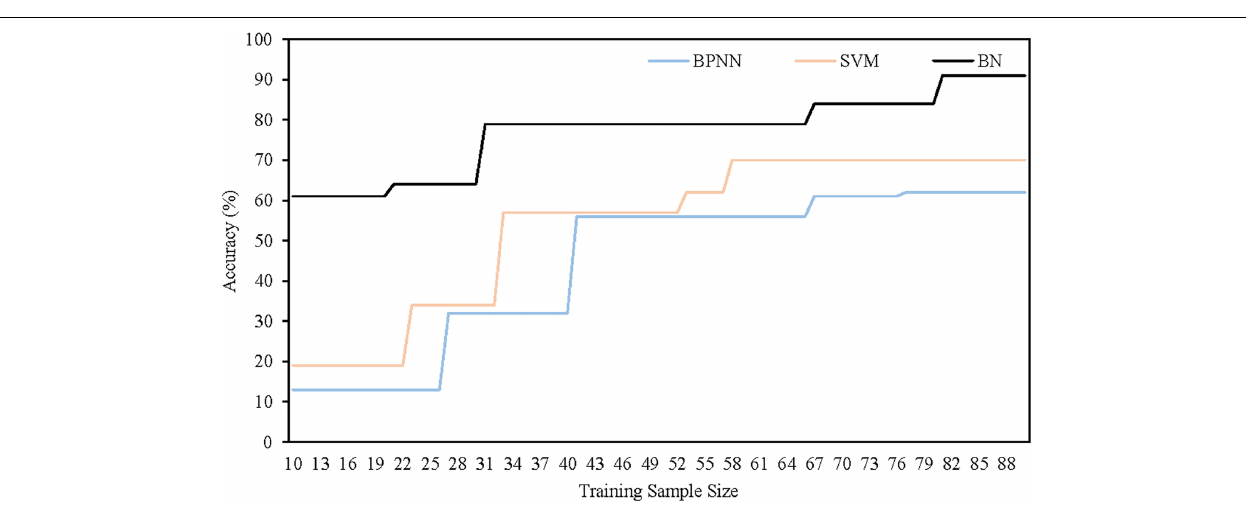
FIGURE 7 | Assessment accuracy of three models with different training samples.